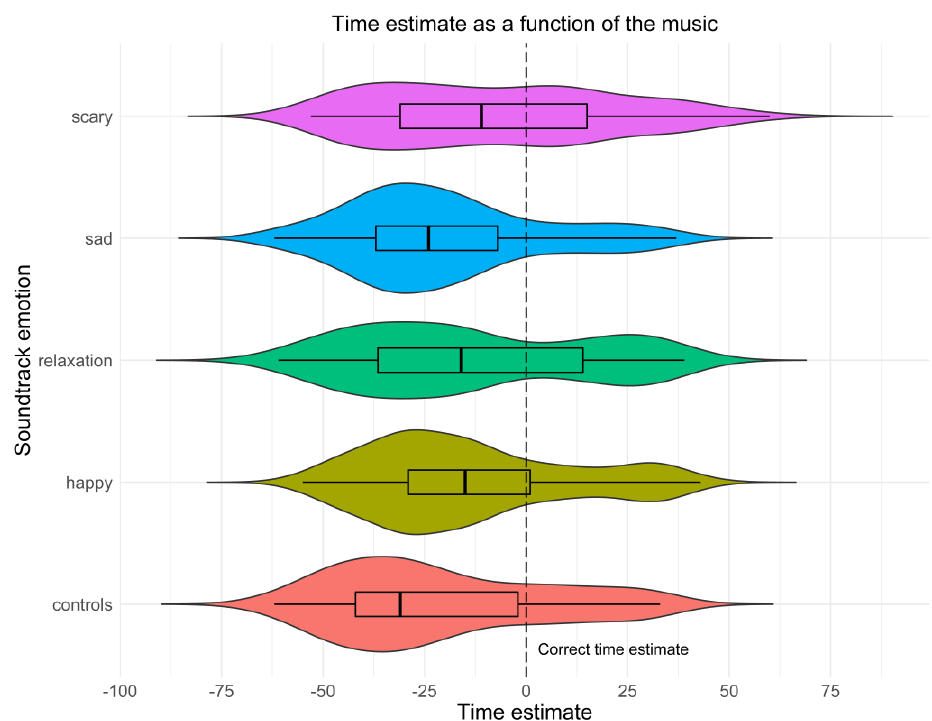
Figure 4. Time estimate (delta) as a function of the soundtrack. The form of the violin indicates the distribution curve. The boxplots within each violin represent interquartile ranges (IQRs). Black vertical lines within the boxplots indicate median values. Values above zero represent overestimation; negative values indicate underestimation. Participants in the happy, relaxation, and scary conditions presented significantly higher time estimations than in the no-music condition (custom hypothesis contrasts). Table 4. Time estimate (delta) as a function of the condition.